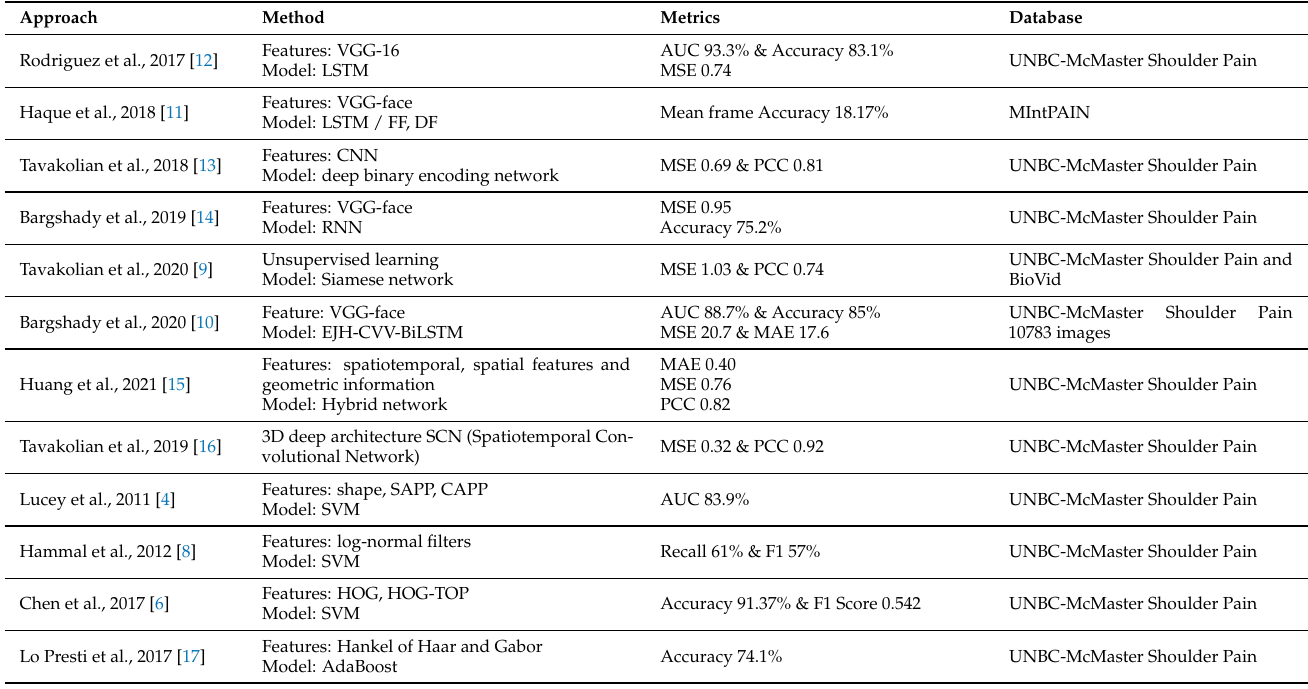
Table 1. Summary of some previous works on pain